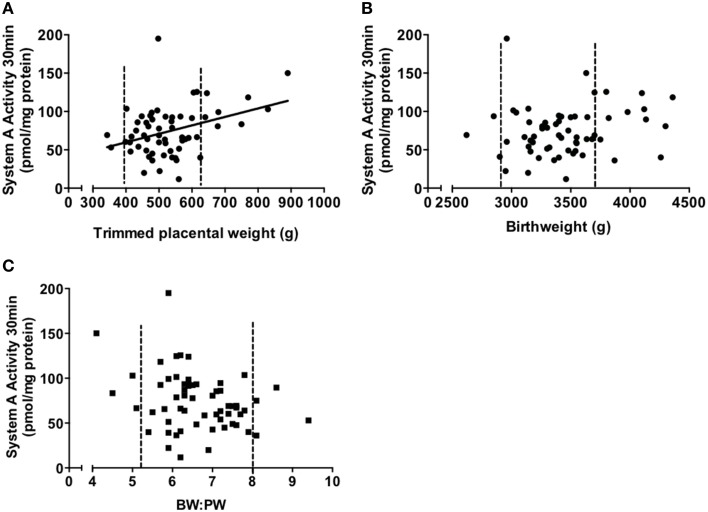
Correlations of system A activity (pmol/mg protein) vs. trimmed placental weight (A), birthweight (B), and BW:PW ratio (C). Data is collated from previously published studies within our laboratory (Ditchfield et al., 2010; Hayward et al., 2012; Lean et al., 2014). Dotted line denotes the 10th and 90th centile of placental weight (A), birthweight (B) and BW:PW ratio (C), respectively. P < 0.05 indicates a significant correlation (Spearman correlation). N = 60, all subjects were from an appropriate for gestational age (AGA) population, defined as >10th and <90th of individualized birthweight centiles.